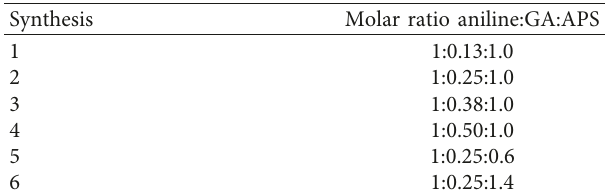
Table 1: The polyaniline synthesis in molar ratios using the monomer amino acid oxidizing agent. Synthesis Molar ratio